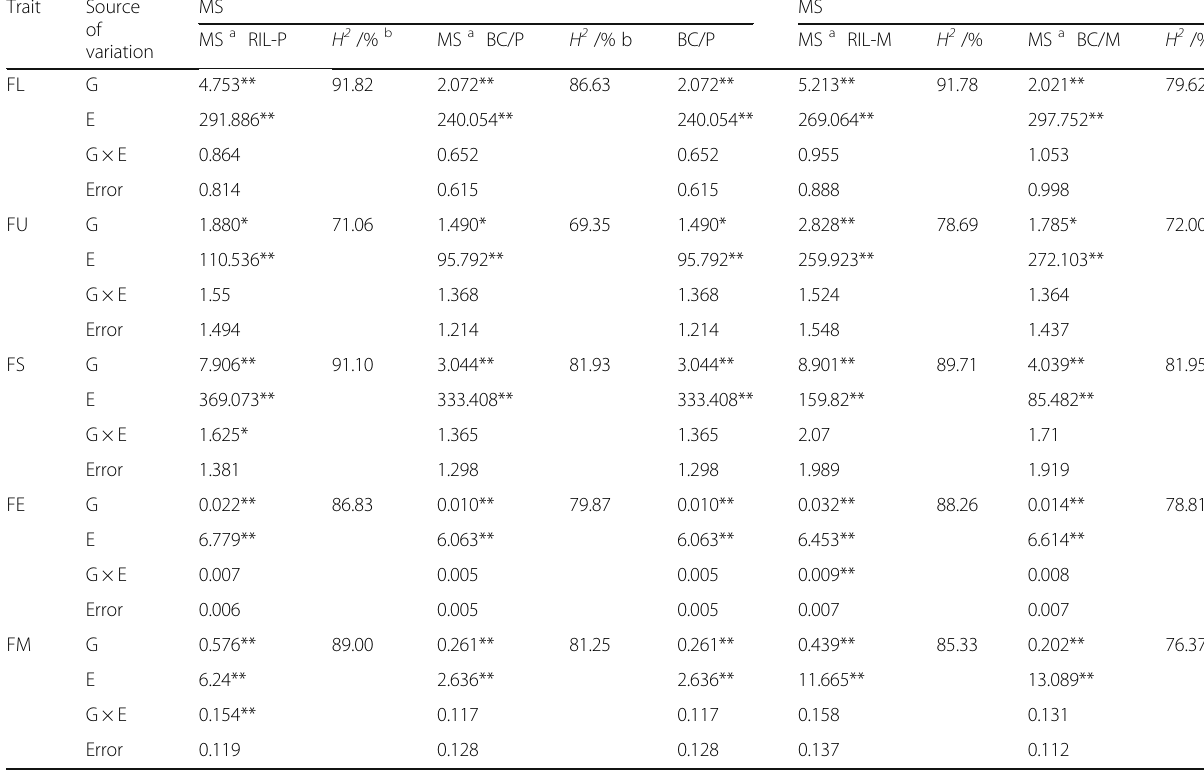
Table 2 Results of ANOVA and heritability for yield and its components in different populations from two backcross trials Trait Source of